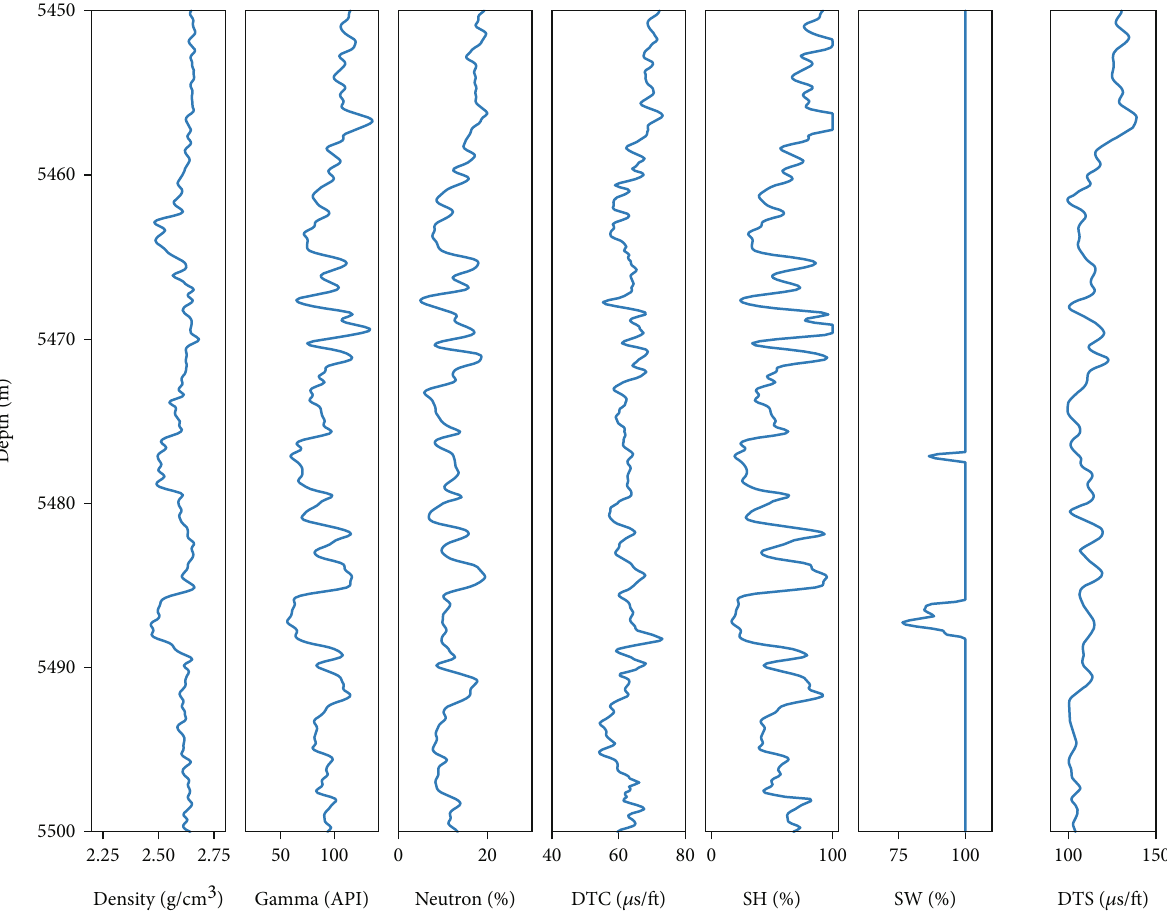
Figure 7: The visualization of logging data.